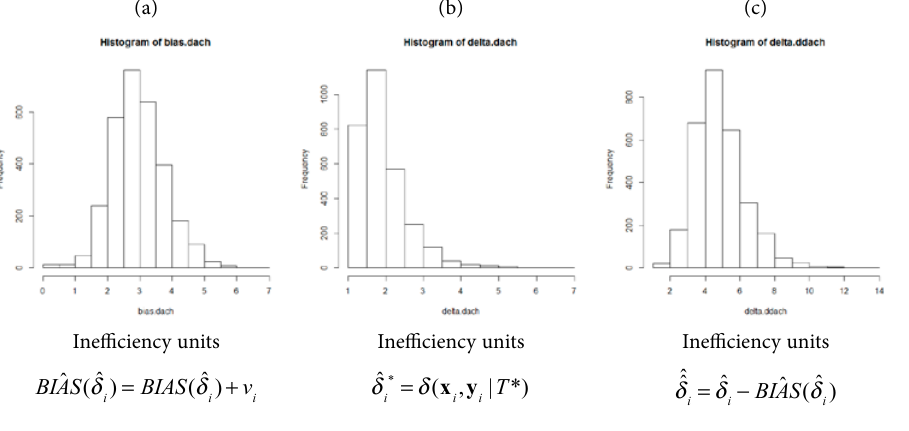
Figure 1. Illustration of inefficiency estimates and estimated bias,